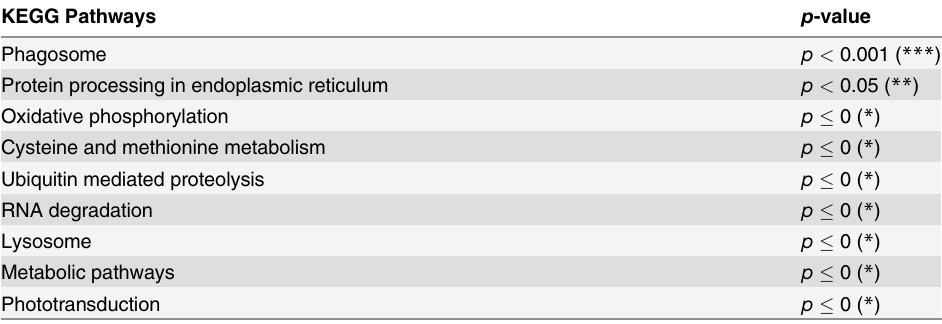
Table 2. Nine signi fi cant KEGG pathways identi fi ed in STRING network. KEGG Pathways p -value Phagosome